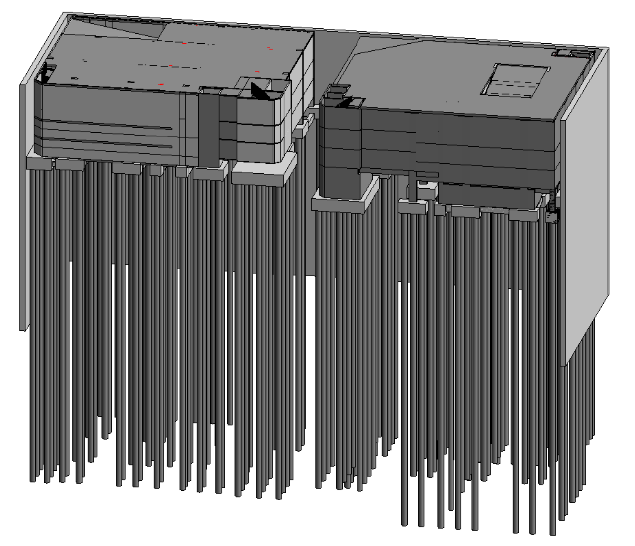
Figure 17. Three-floor basement of office building construction in the 3D model.